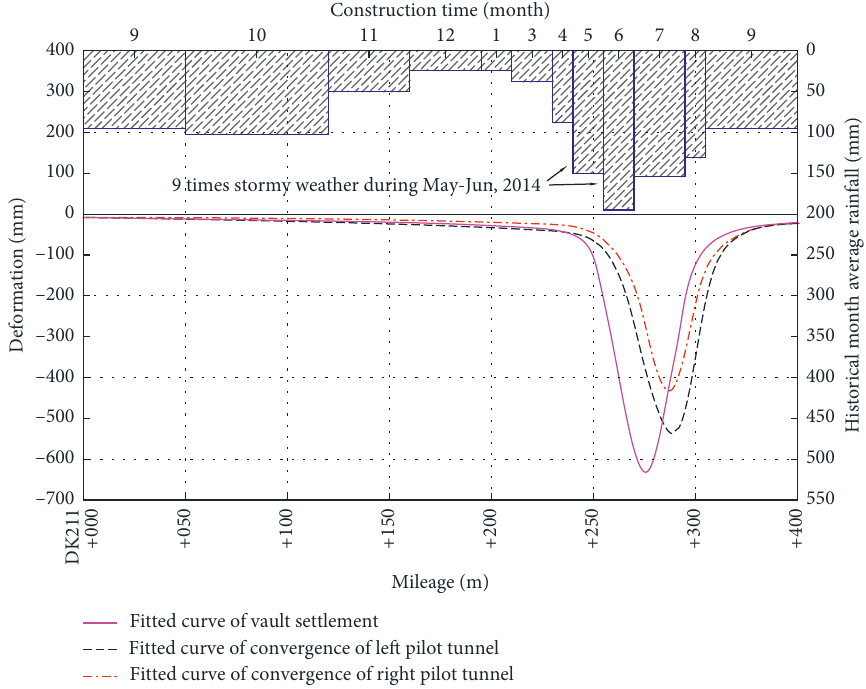
Figure 11: Distribution diagram of surrounding rock deformation and monthly precipitation during